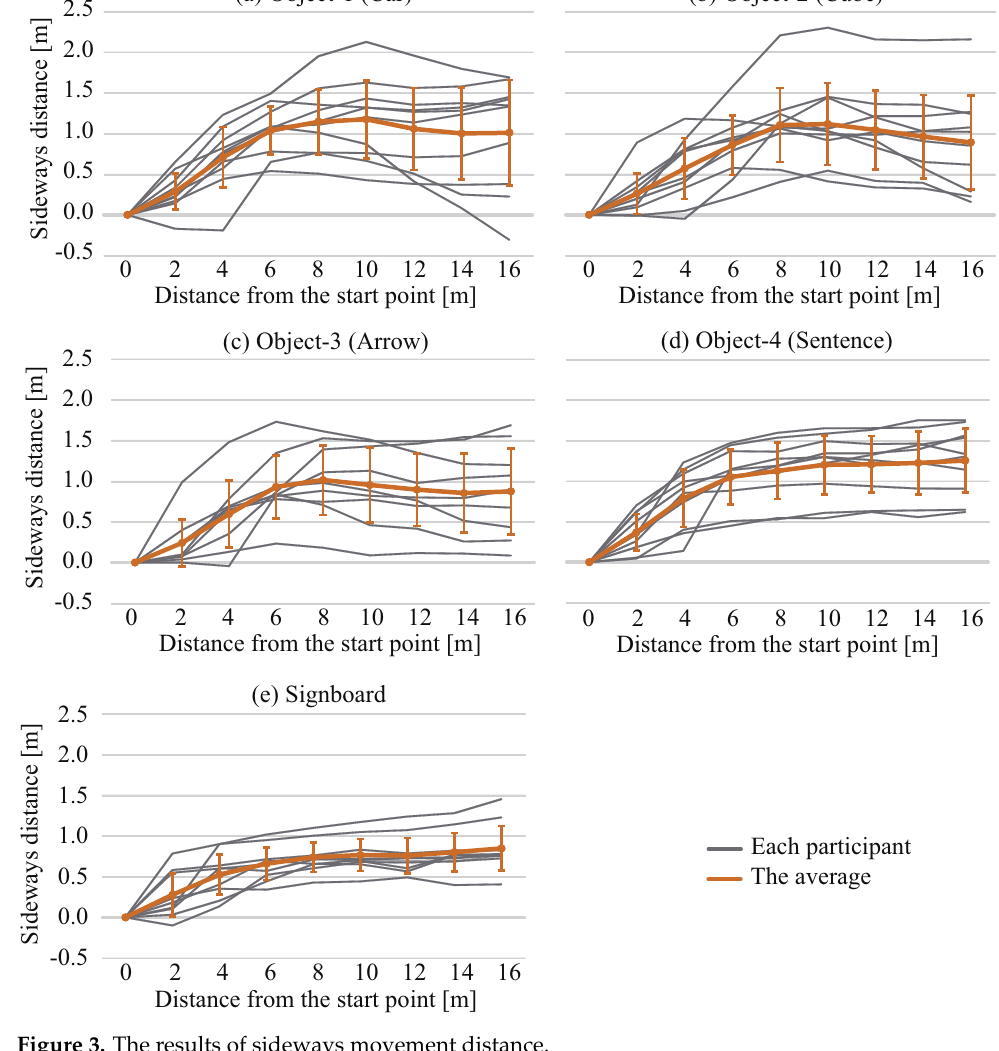
Figure 3. The results of sideways movement